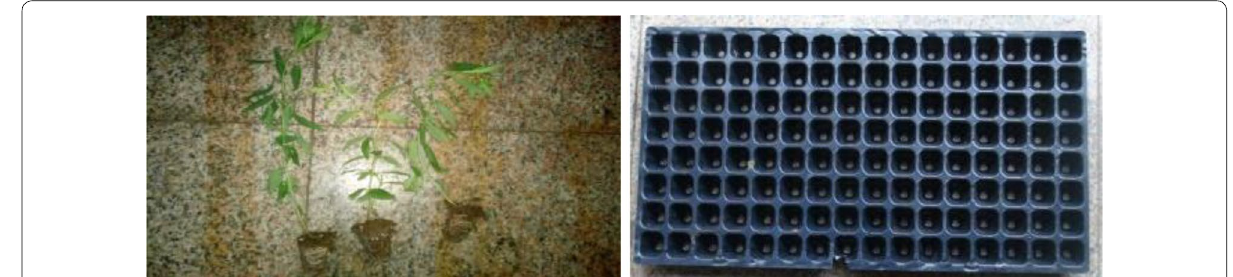
Figure 12 Plug tray and Cordate houttuynia seedlings used for the tests